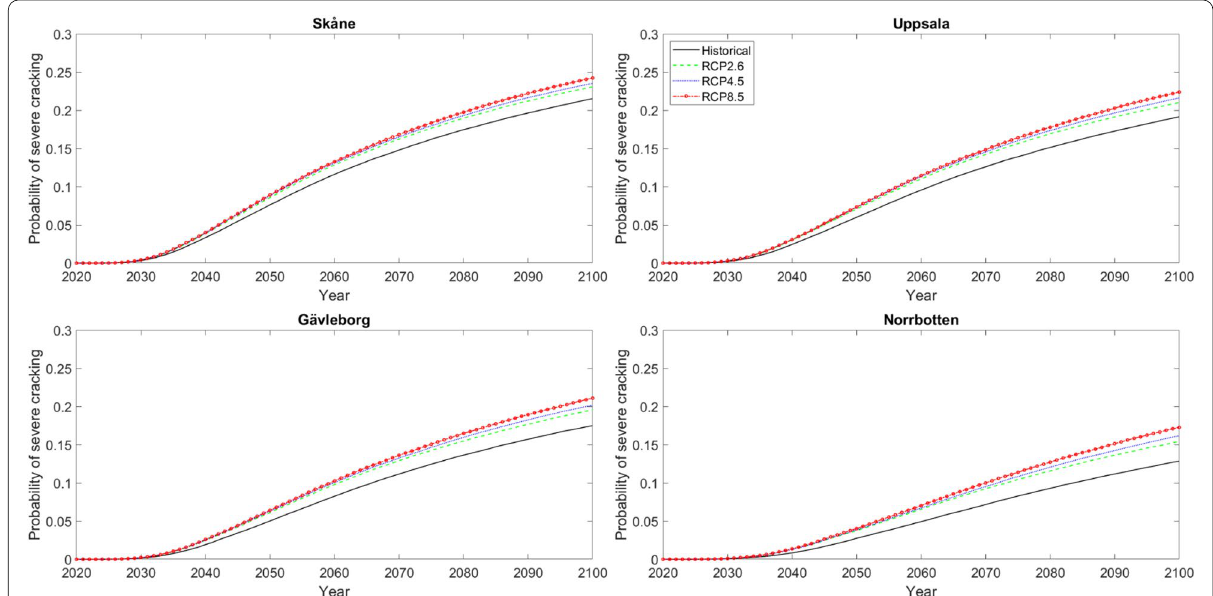
Fig. 7 Probability of severe cracking for the studied beam under the historical (1961 – 1990) and future climatic conditions for Skåne, Uppsala, Gävleborg, and